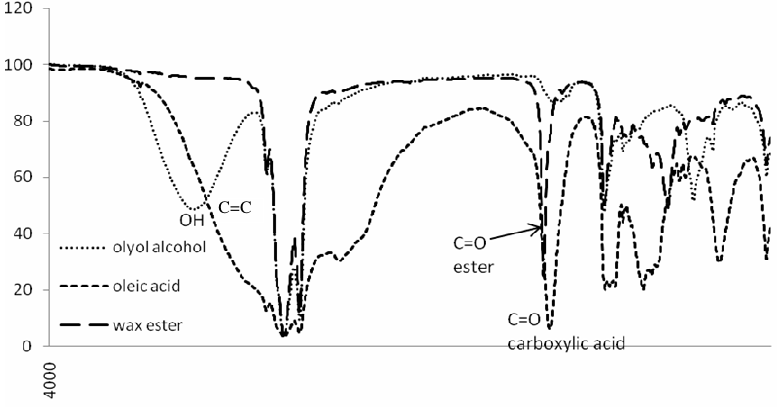
Figure 6. The FTIR spectra of oleyl oleat, oleic acid and oleyl alcohol Table 2. The main signals present in 13 C-NMR functional groups of oleyl oleate Assignment